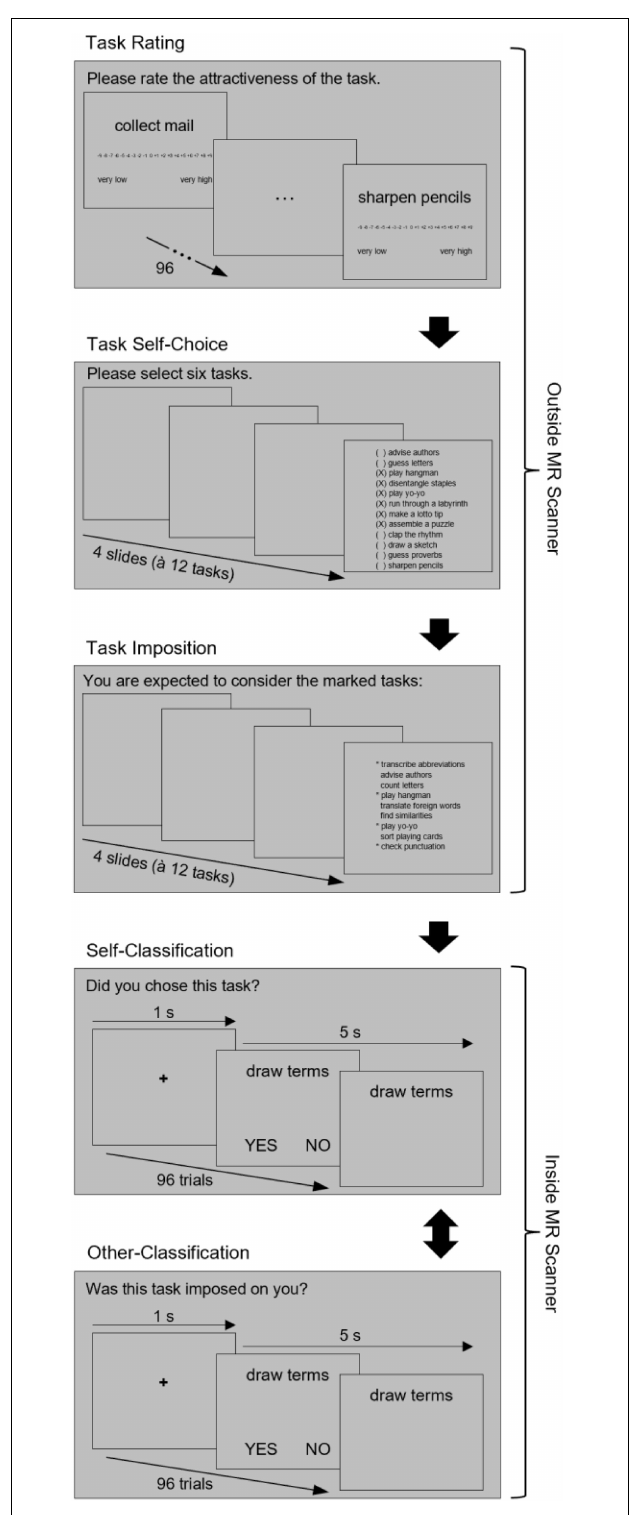
FIGURE 1 | Study design: phases (blocks) of the self-other goal differentiation procedure and their components. While the sequential order of the first three phases was the same for all participants, the last two phases were counterbalanced between